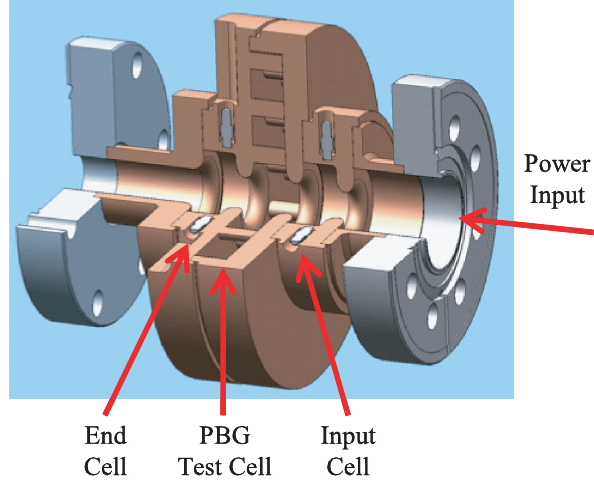
FIG. 1. Single cell standing wave PBG structure.